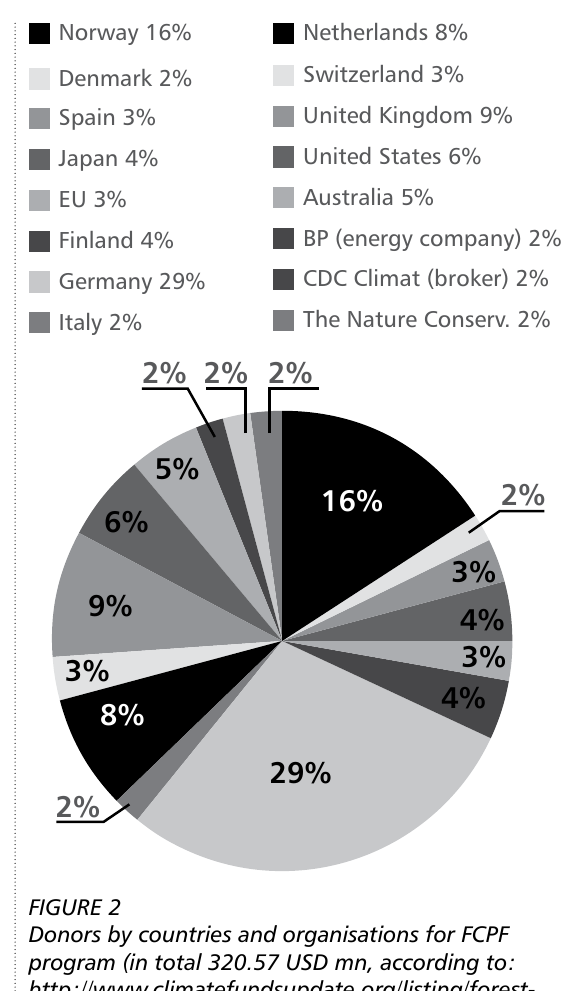
Donors by countries and organisations for